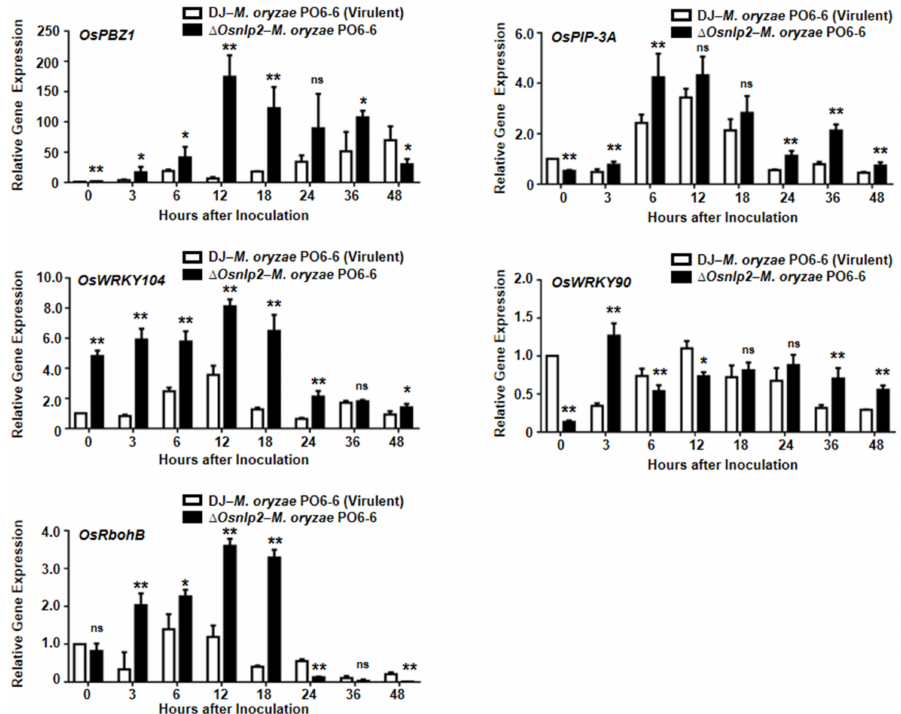
Figure 8. Real-time qRT-PCR analysis of time-course expression of some defense-related genes in leaf sheaths of rice DJ and ∆ Osnlp2 mutant (#4-2) plants during virulent Magnaporthe oryzae PO6-6 infection. Relative expression levels of OsPBZ1 , OsPIP-3A , OsWRKY104 , OsWRKY90 , and OsRbohB at different time points after inoculation were obtained by normalizing with respect to the expression levels of the internal control OsUbiquitin . The data are means ± SD of relative gene expression levels in rice leaf sheaths from three independent experiments. Asterisks indicate significant differences as determined by Student’s t -test ( p < 0.05, p < 0.01). ns, not